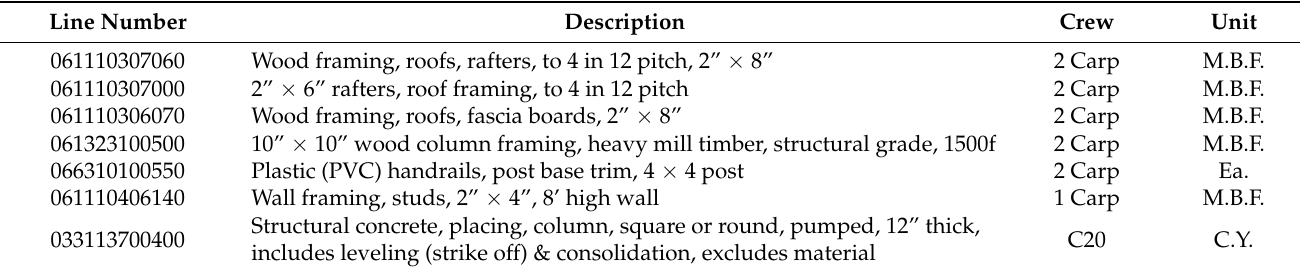
Table 3. Cost item examples from RSMeans online